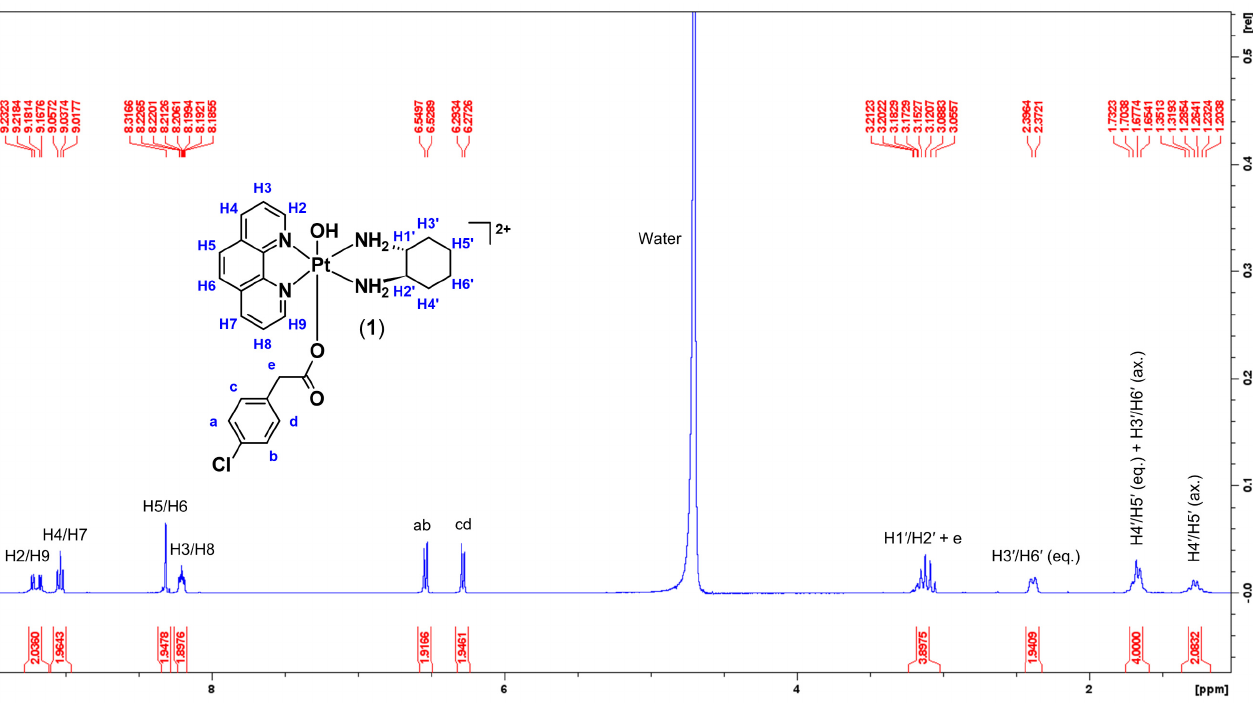
Figure 9. 1 H − NMR spectrum of 1 in D 2 O obtained at 298 K, with proton assignment. Inset: structure of 1 with proton labelling system.